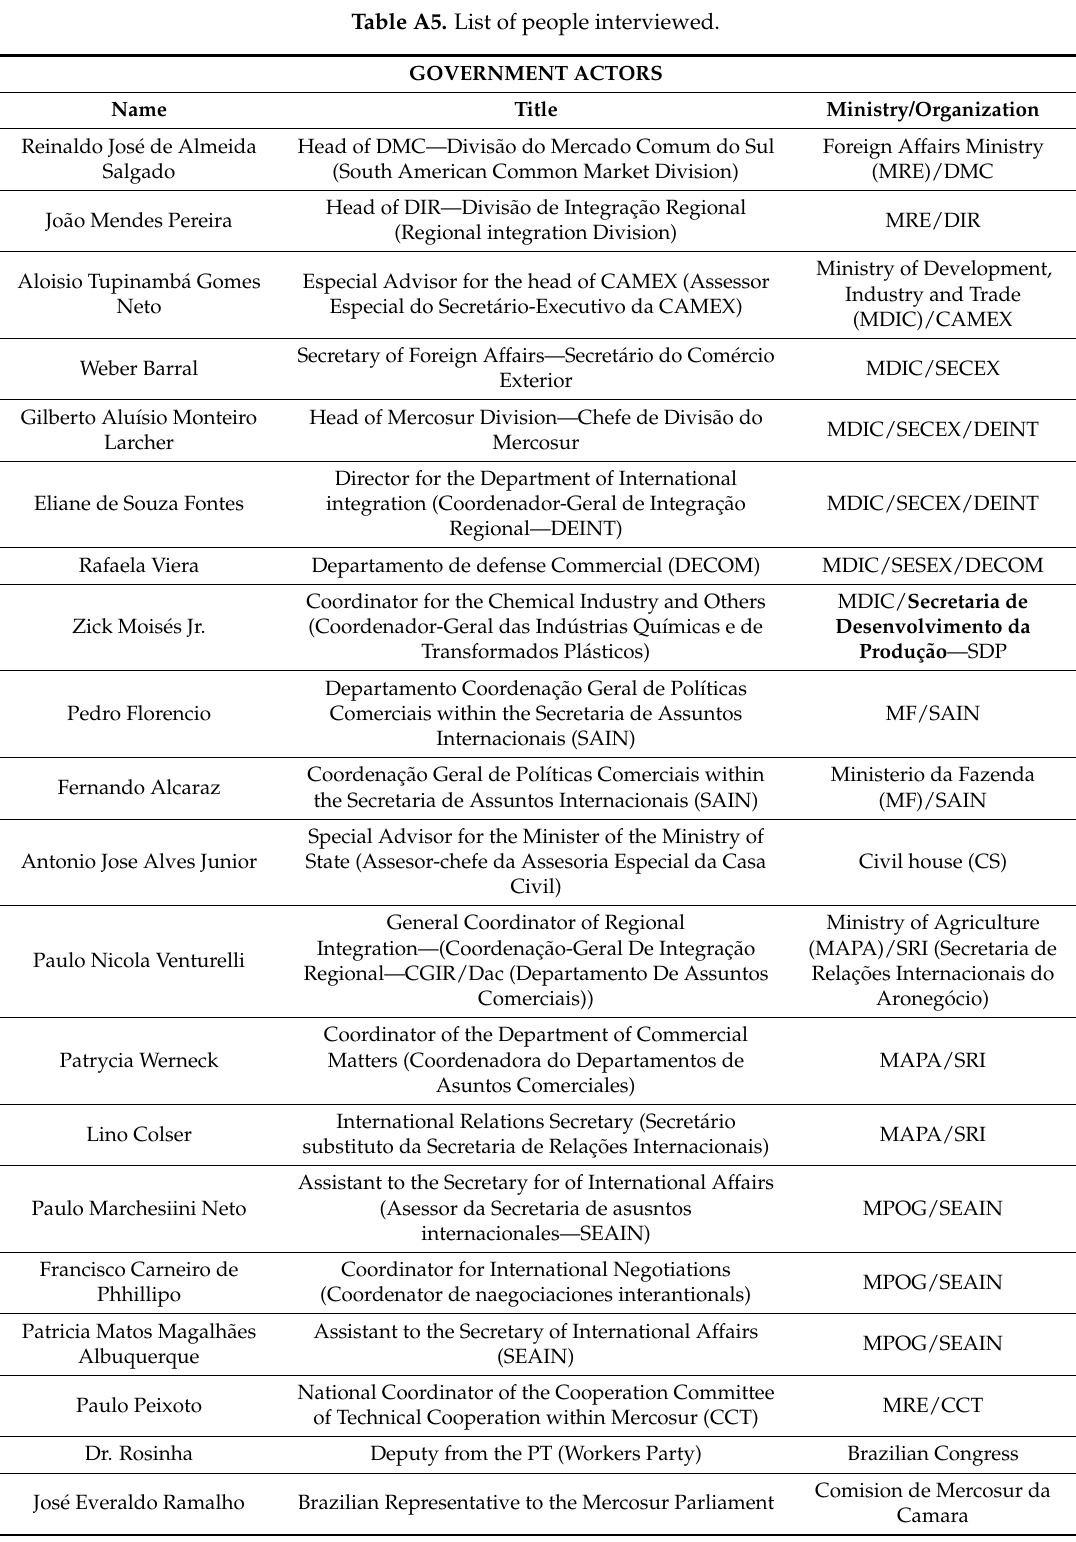
Table A5. List of people